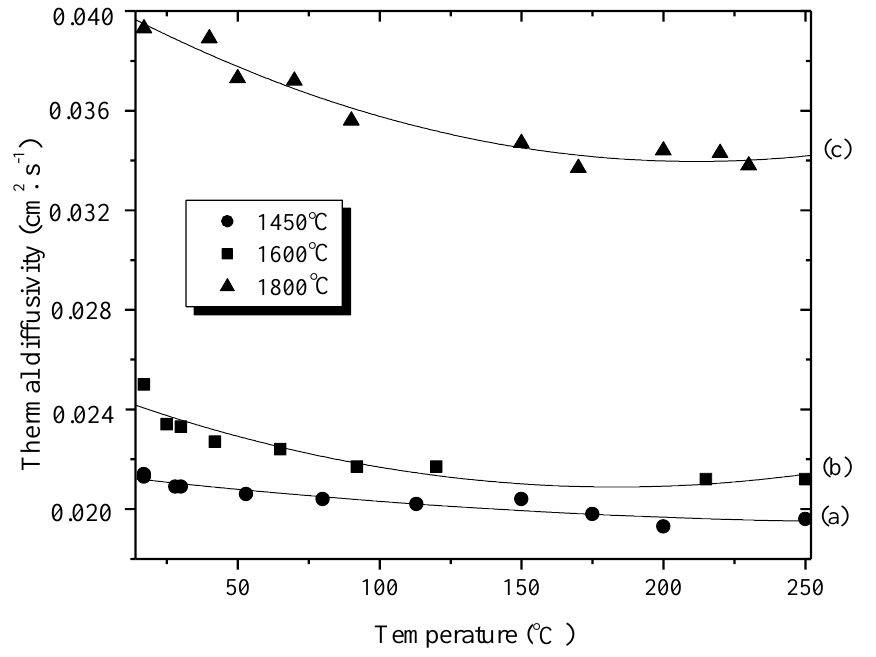
Figure 7. Temperature dependence of the thermal diffusivity of typical disk-shaped samples with warm-pressing pressure under 74 MPa at 60 °C (dwelling time of 0.5 h) and